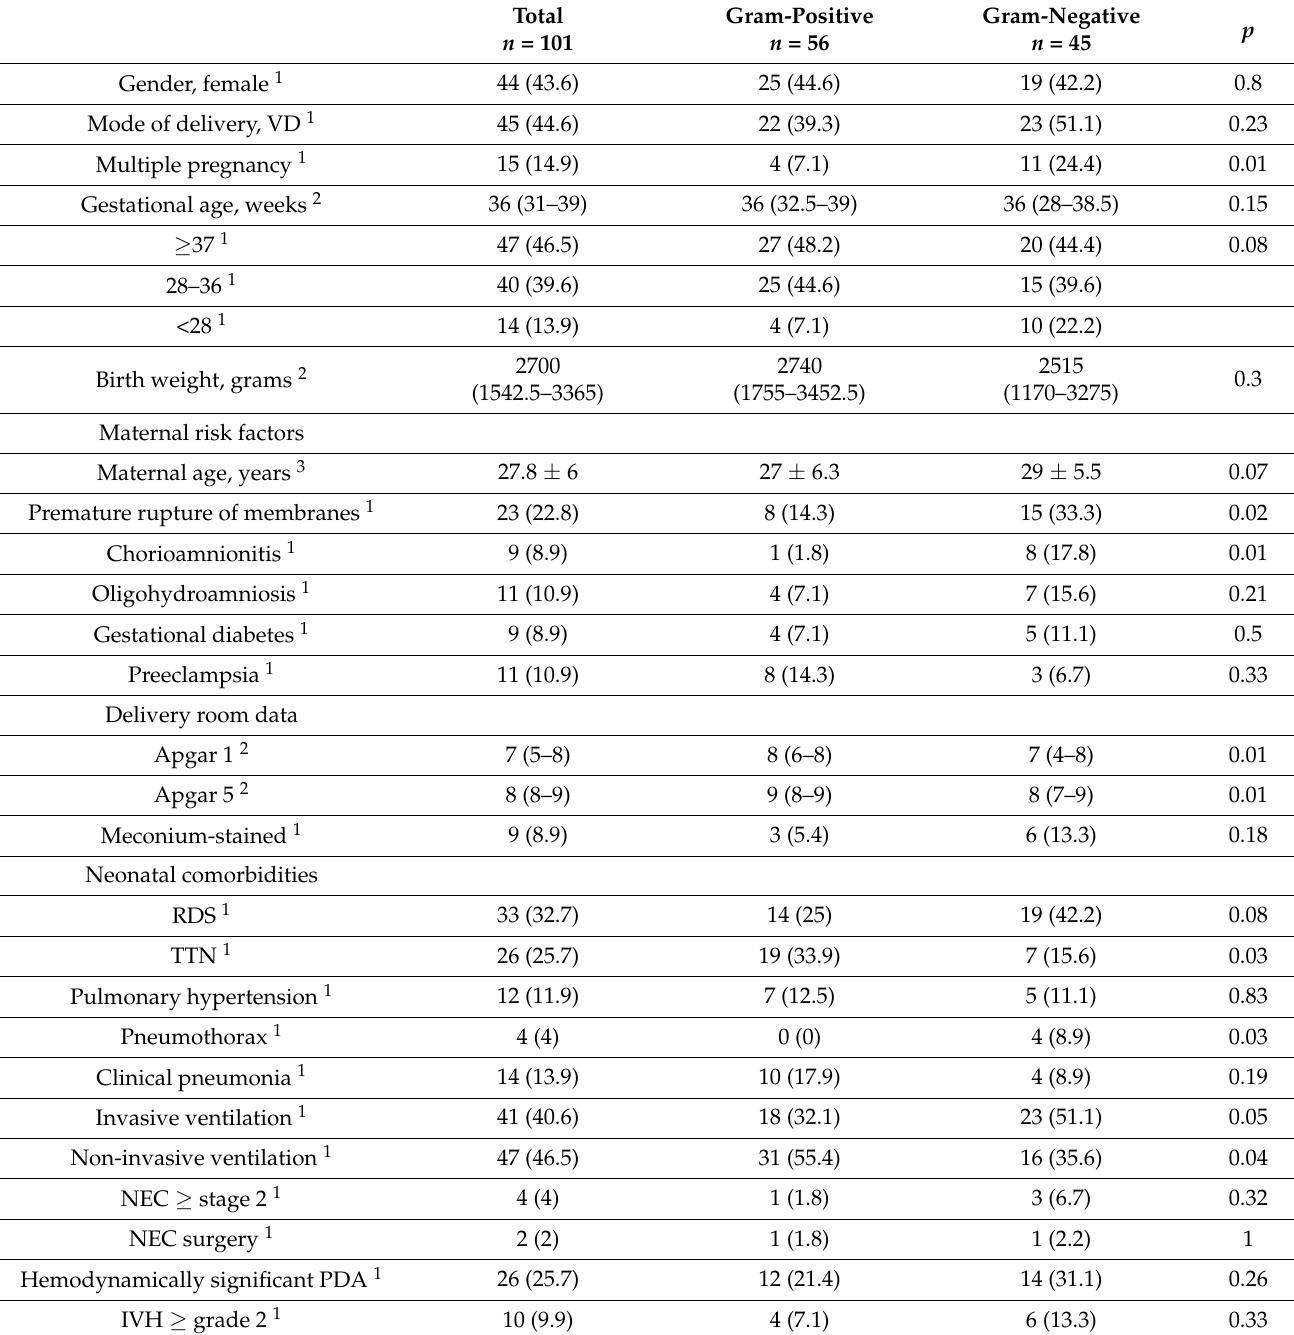
Table 2. Neonatal and maternal demographics of the patients according to blood culture